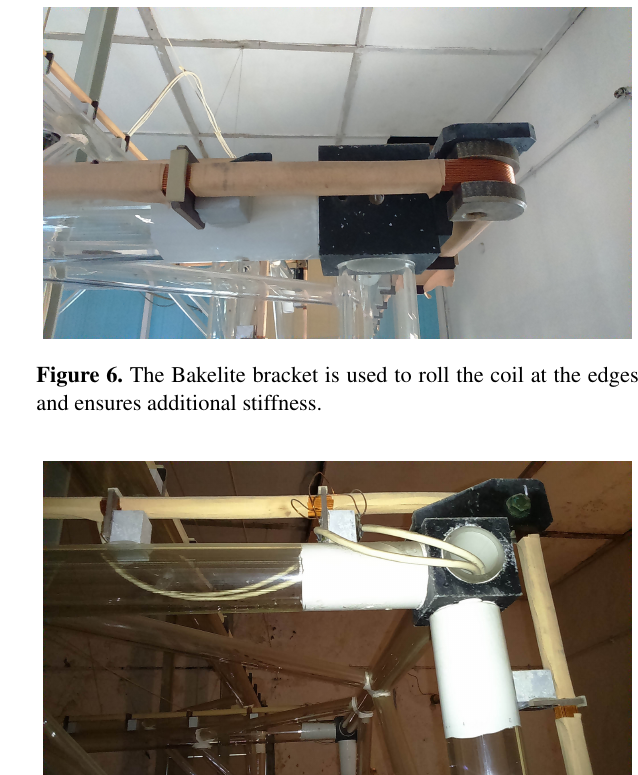
Figure 7. The coils are supported by a borosilicate glass piping con- struction to electrically isolate the coils from the support structure. The primary glass support structure is joined to the end corners us- ing a female square-design six-way cross aluminium connector to which a Bakelite bracket is fixed using a nut and